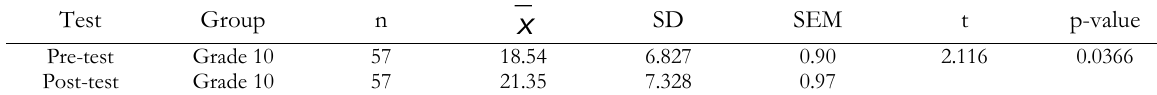
Table 2. Statistical results of the t-test analysis for the achievement test (FMAT) Test